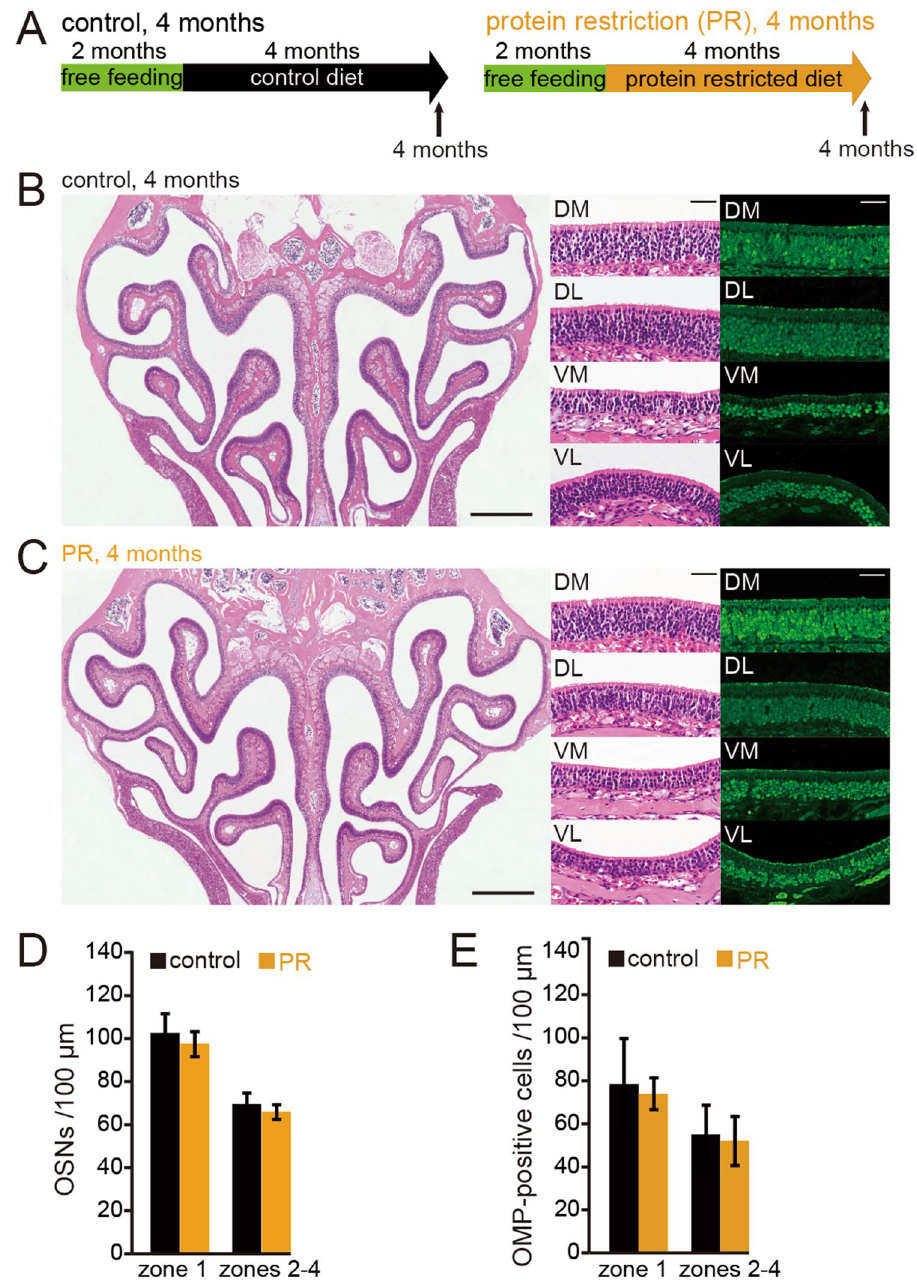
Figure 6. Long-term PR could be required for zone-1-specific injury. ( A ) Time course of the experimental design. Control, 4 months on control diet; PR, 4 months on protein-restricted diet. ( B , C ) Photomicrographs of representative coronal sections of the OE in control ( B ) and PR mice ( C ). Left images, low magnification; middle (HE-staining) and right images (anti-OMP staining), high magnification. Scale 300 µm at low magnification, 50 µm at high magnification. ( D , E ) Number of OSNs ( D ) and number of OMP-positive cells ( E ) in zone 1 and zones 2–4. No significant histological differences were observed between control and PR mice in any zone (Mann–Whitney